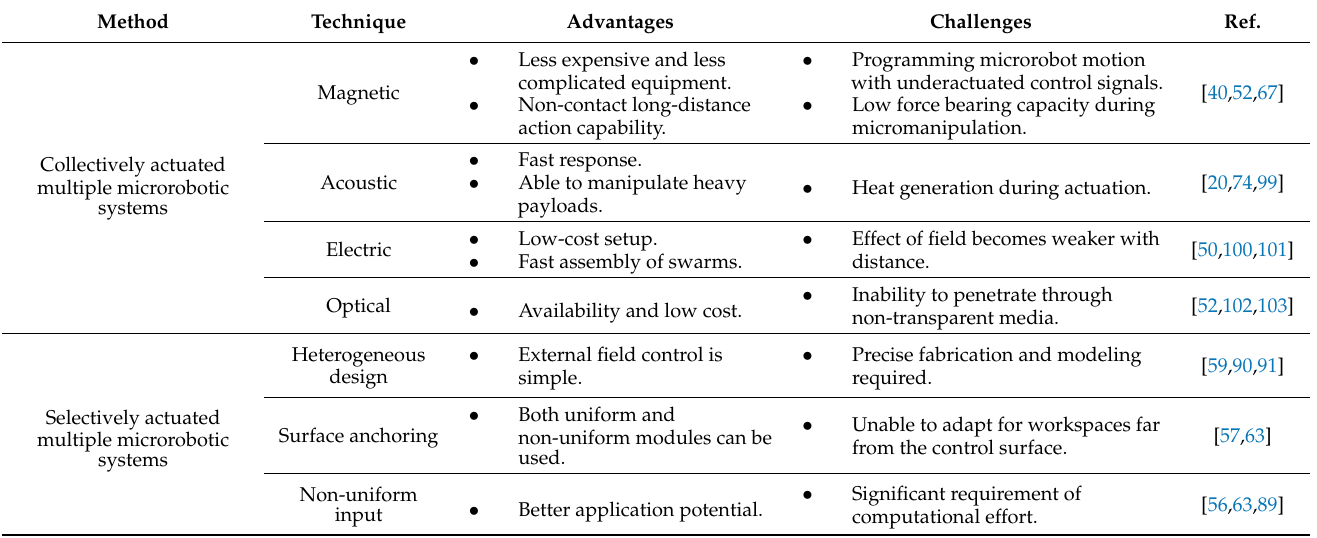
Table 2. Advantages and challenges of different shape forming